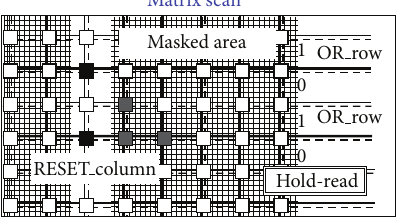
Figure 9: Readout starts for the first enabled column.